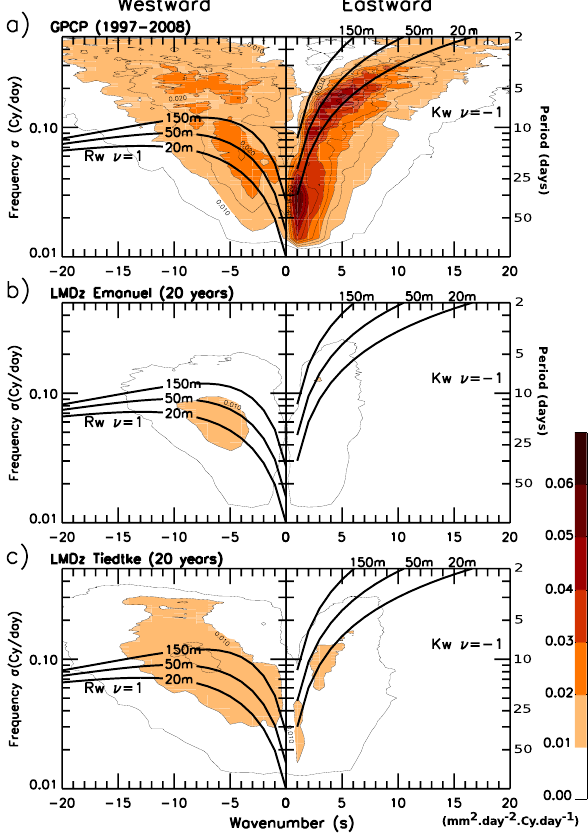
Fig. 2. Wave-number–frequency spectra of the symmetric compo- nent of the precipitation averaged over latitude range from 10 ◦ S to 10 ◦ N (units are in mm 2 j − 2 Cyj − 1 ): (a) GPCP, (b) LMDz-E, and (c) LMDz-T. Contour intervals are 0.01mm 2 j − 2 Cyj − 1 for the shaded areas and 0.005mm 2 j − 2 Cyj − 1 for the thin solid lines. The light (dark) colours show relatively low (high) precipitation spec- trum values. The superimposed dispersion curves (thick solid lines) are calculated from Eq. (3) for the KWs ( ν = − 1) in the eastward panels and for the Rossby waves ( ν = + 1) in the westward panels. They are displayed for the three equivalent depths h = 20 , 50 and